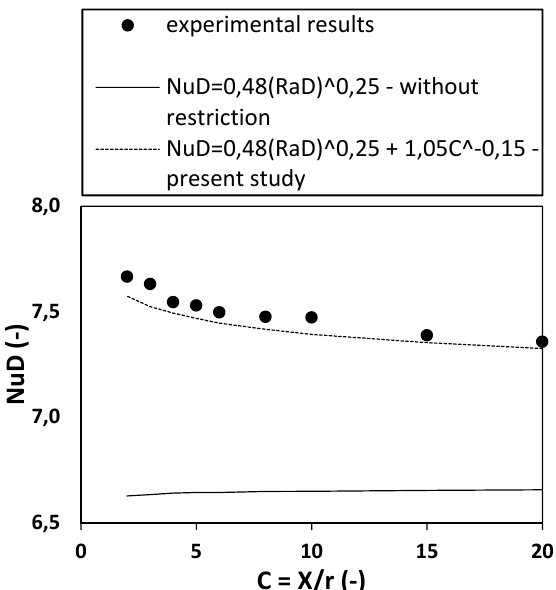
Fig. 11. Correlation between average Nusselt number versus confinement ratio for highest q = 796 W/m